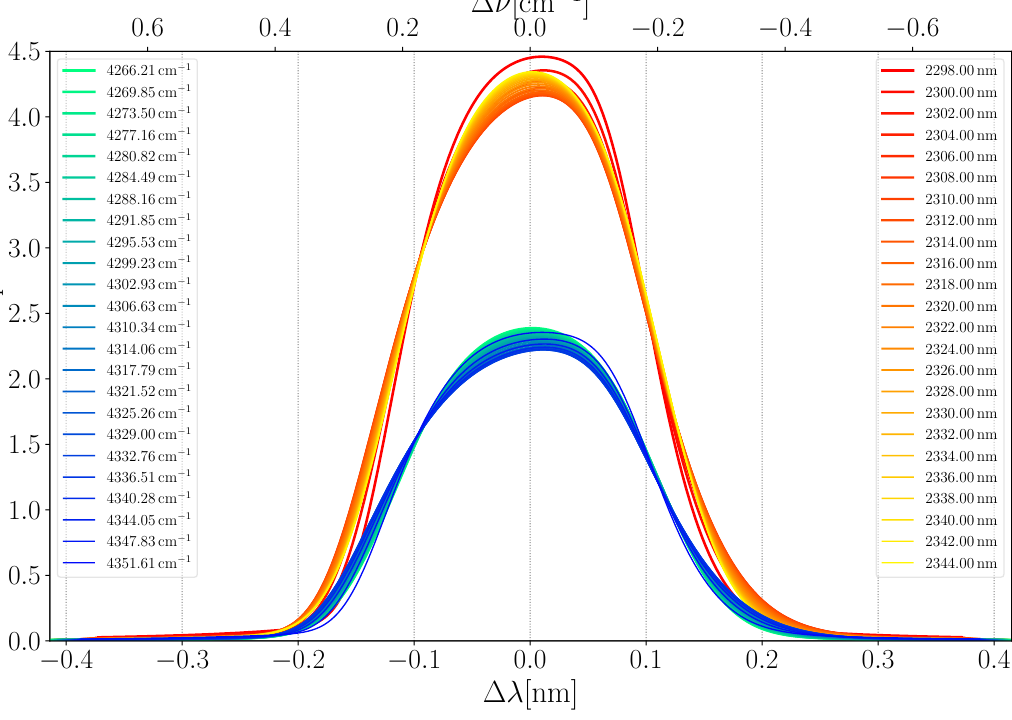
+ ∞ (cid:82) ( x ) d x = 1 in the wavelength ( x = λ ) and ij ∞ S −